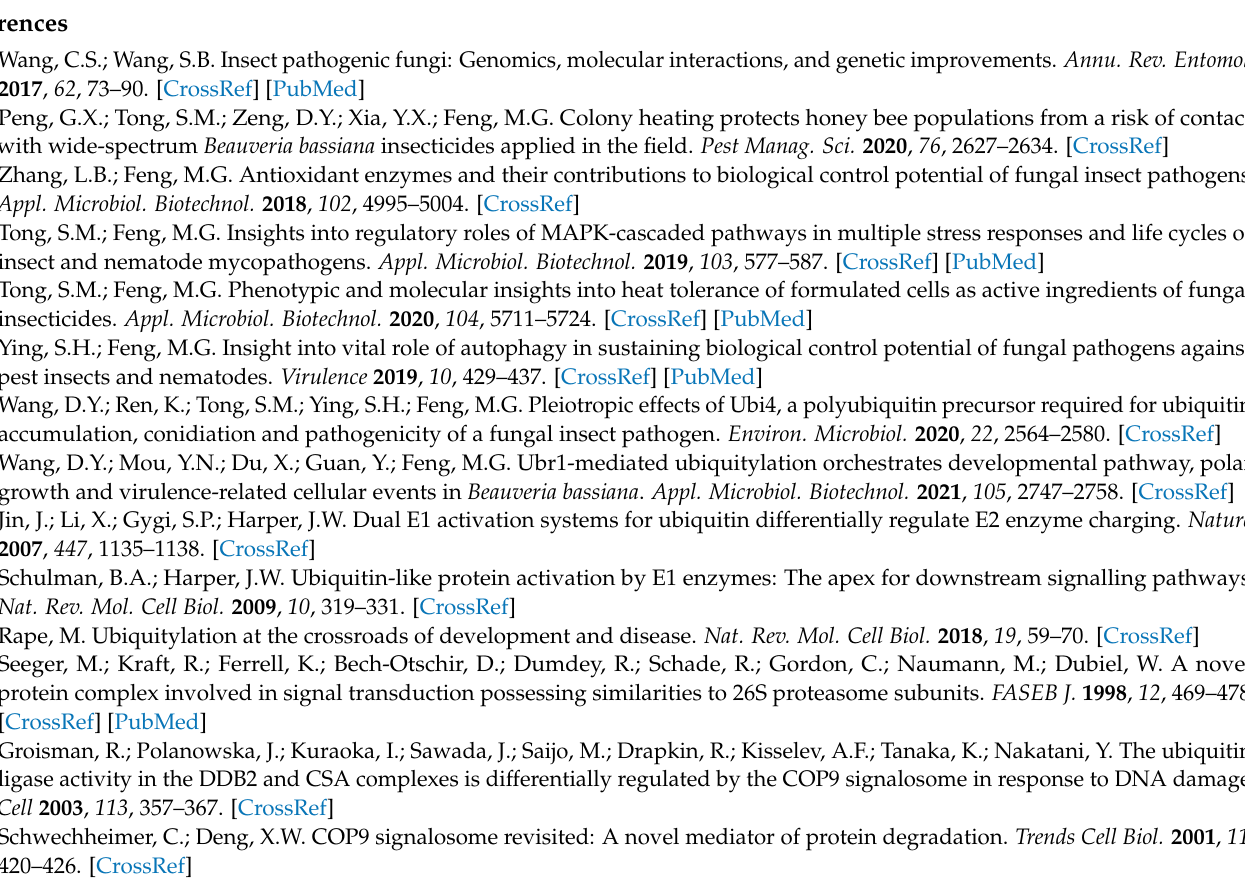
Table S2: Paired primers used for transcriptional profiling of csn5 -related genes in B. bassiana ; Figure S1: Generation and identification of csn5 mutants in B. bassiana ; Figure S2: Phylogenetic relationships and sequence features of Csn5 orthologues found in entomopathogenic (Hypocreales) and nonentomopathogenic fungi; Figure S3: Phylogenetic relationships of CSN subunits between B. bassiana and two model fungi; Figure S4: Impact of csn5 deletion on accumulation levels of intracellular free ubiquitin and expression levels of putative UPS genes in B. bassiana